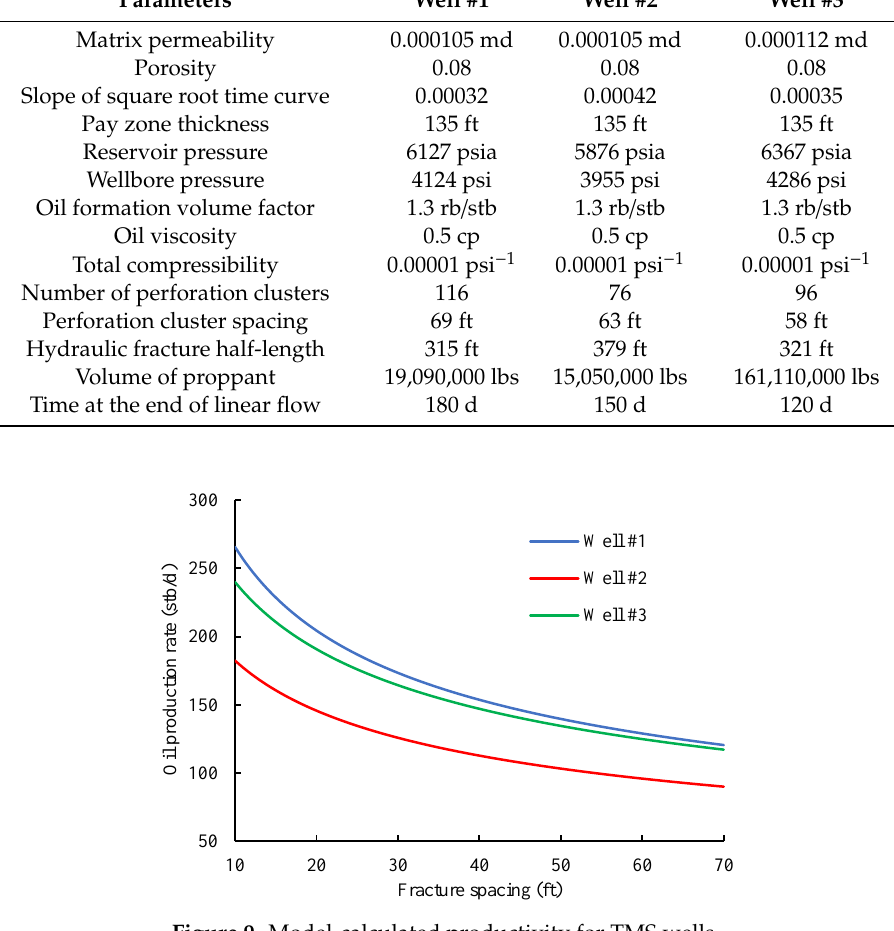
Figure 9. Model-calculated productivity for TMS